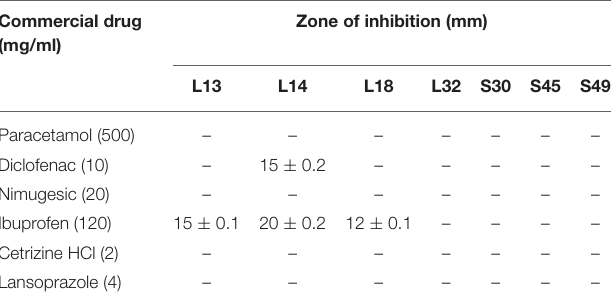
TABLE 7 | Effect of commercially available drugs on growth of lactobacilli isolates. Commercial drug